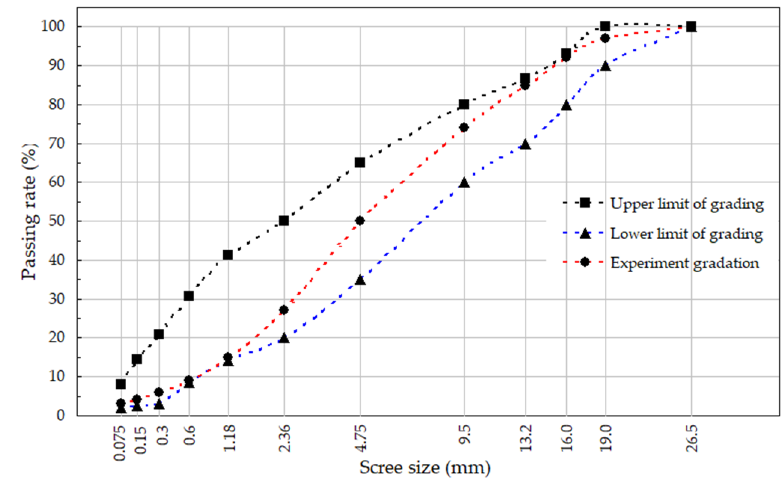
Figure 1. Grade curve of the experimental gradation.